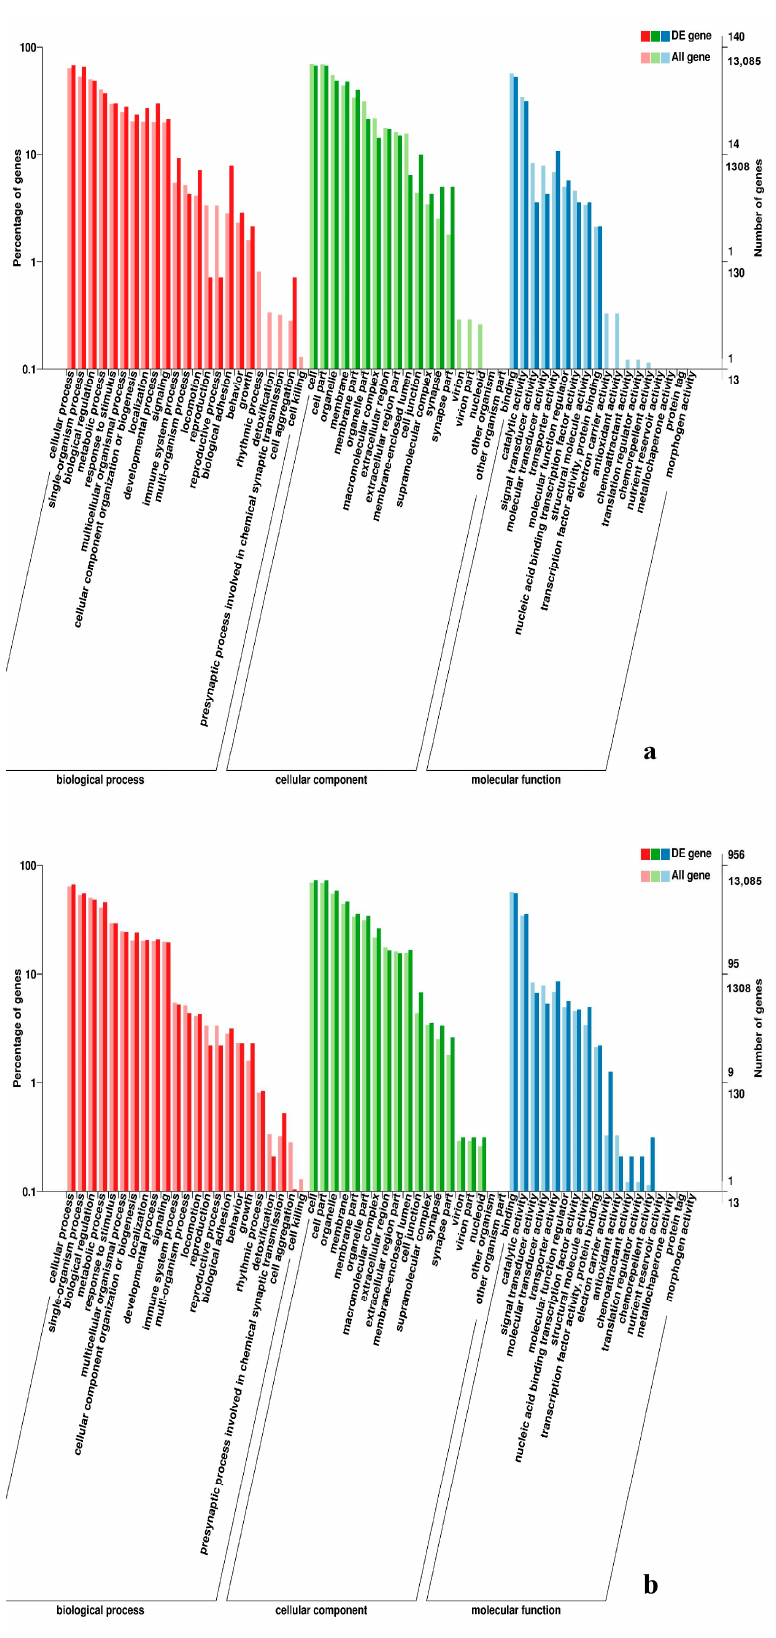
Figure 10. GO enrichment analysis of DEGs in the comparison of breast and leg